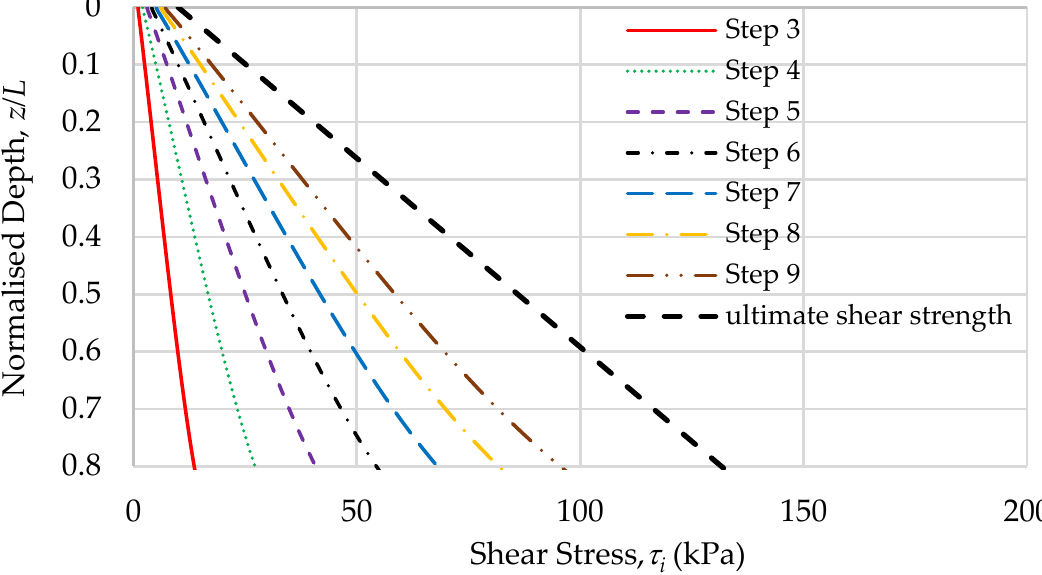
Figure 6. Shear stress and modulus profile along the pile shaft.